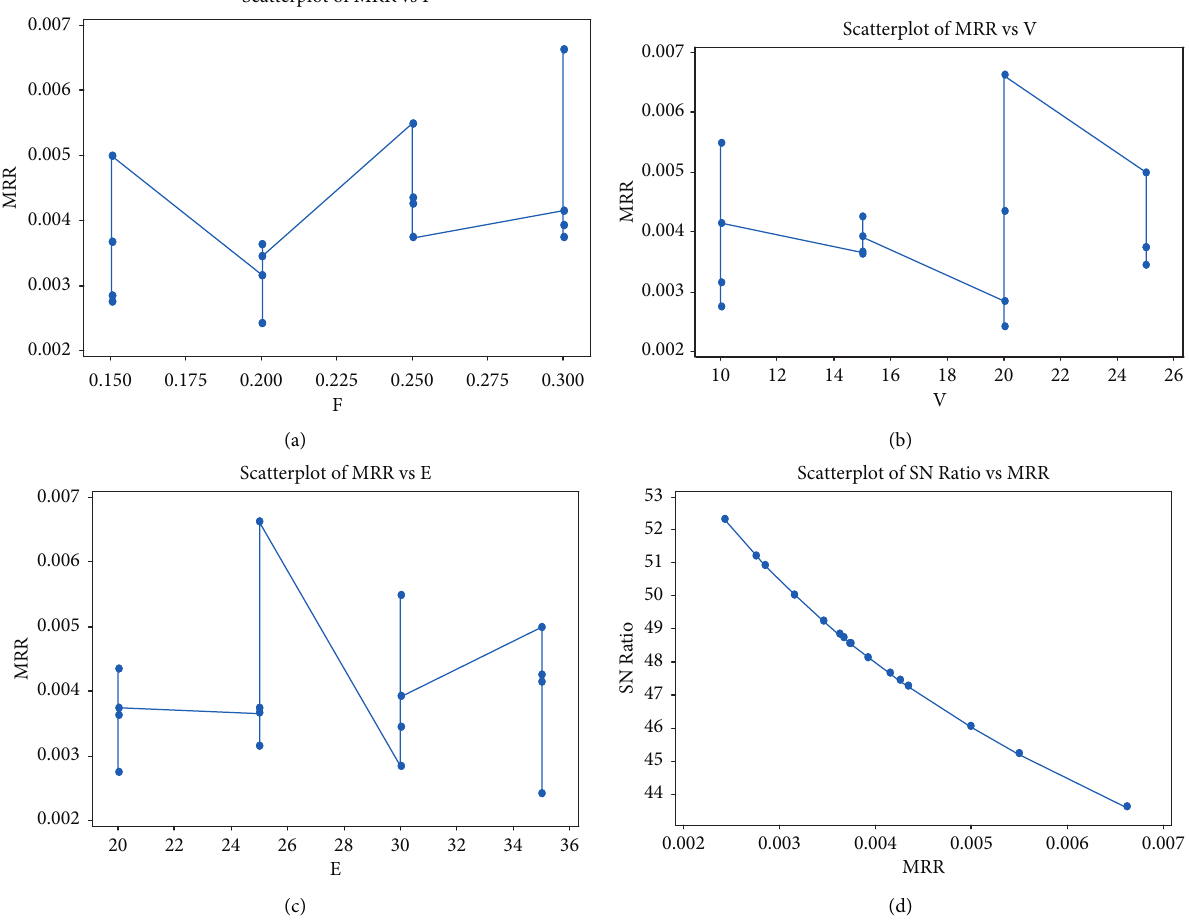
Figure 4: (a): MRR vs. feed rate. (b) MRR vs. voltage. (c) MRR vs. electrolyte concentration. (d) MRR vs. SN ratio.